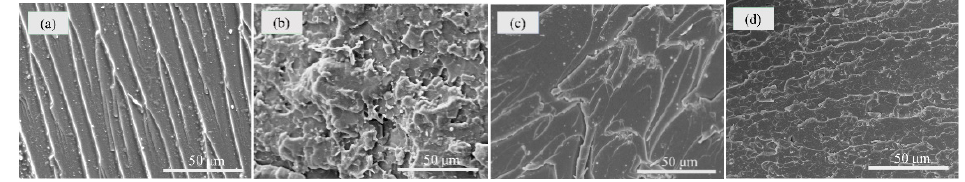
Figure 9. The SEM images of the fractured surface of pure epoxy resin (EP) ( a ), EP-4% PDPG ( b ), EP-2% GO-MD-MP ( c ), and EP-4% GO-MD-MP ( d ) composites.